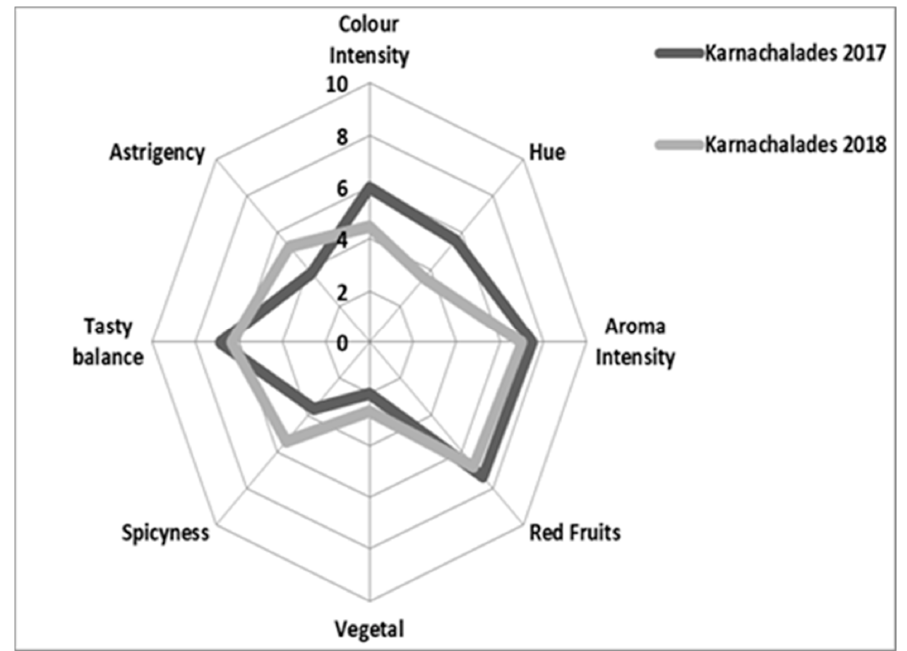
Figure 7. Sensory profile (Spider Diagram) of “Karnachalades” wines in two consecutive years, outlined by a group of professional tasters from the Laboratory of Enology and Alcoholic Beverages of the Agricultural University of Athens. The centers of the diagrams represent the lower values with the tension of each attribute increasing to an intensity of the digit 10 at the perimeter.